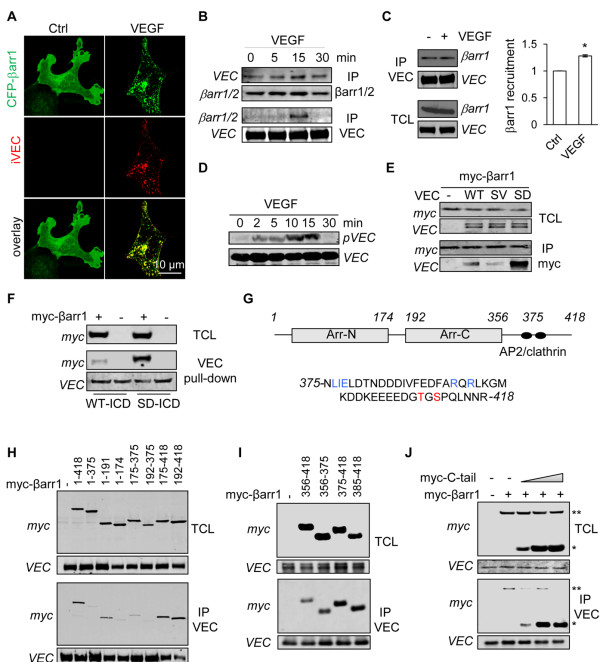
β-arrestin1 C-terminus tail binds to S665D VE-cadherin mutant. (A) HUVEC were transfected with CFP-myc-tagged β-arrestin1 (CFP-βarr1, green). After serum deprivation, cells were subjected to VE-cadherin internalization assay, stimulated with VEGF (50 ng/ml, 15 min) and fixed for staining (iVEC, red). Cells were analyzed by confocal microscopy. Scale bar: 10 μm. (B-D) After overnight serum starvation, three day-old HUVEC were stimulated with VEGF (50 ng/ml) for the indicated times. (B-C) The anti-VE-cadherin (VEC) and anti-β-arrestin1/2 (βarr1/2) immunoprecipitated (IP) fractions were analyzed by western-blot. Densitometry analysis was done with Image J software. T-test: * p < 0.05. (D) Total cell lysates (TCL) were analyzed by western-blot for S665 phosphorylation of VE-cadherin (pVEC) and total VEC. (E) HEK-293T cells were co-transfected with CFP-myc-tagged β-arrestin1 (myc-βarr1) together with control plasmid (−), wild-type (WT), non-phosphorylable (SV) or phosphomimetic (SD) VE-cadherin mutants. TCL and IP fractions were analyzed by western-blot as indicated. (F) HEK-293T cells were transfected with CFP-myc-β-arrestin1 (myc-βarr1, +) or CFP-myc control plasmid (−). Cellular extract was incubated with recombinant histidine-fused VE-cadherin intracellular domain (ICD), either WT or SD. TCL and pull-down fractions were analyzed by western-blot as indicated. (G) Schematic representation of human β-arrestin1, with two arrestin (arr) domains. The C-terminus tail (375–418) comprises an AP2 binding site (LIE and RXR in blue) and two phosphorylation sites (in red). (H-J) HEK-293T cells were co-transfected with VEC SD mutant together with control plasmid (−), full-length and deleted forms of myc-βarr1. IP fractions and TCL were analyzed by western-blot. (J) HEK-293T cells were co-transfected with VEC SD mutant together with a constant amount of full-length myc-βarr1 (**) and increasing concentrations of CFP-myc-tagged β-arrestin1 C-terminus tail comprising amino acids 475–418 (myc-C-tail, *). TCL and IP fractions were analyzed by western-blot. All panels are representative of at least 3 independent experiments.